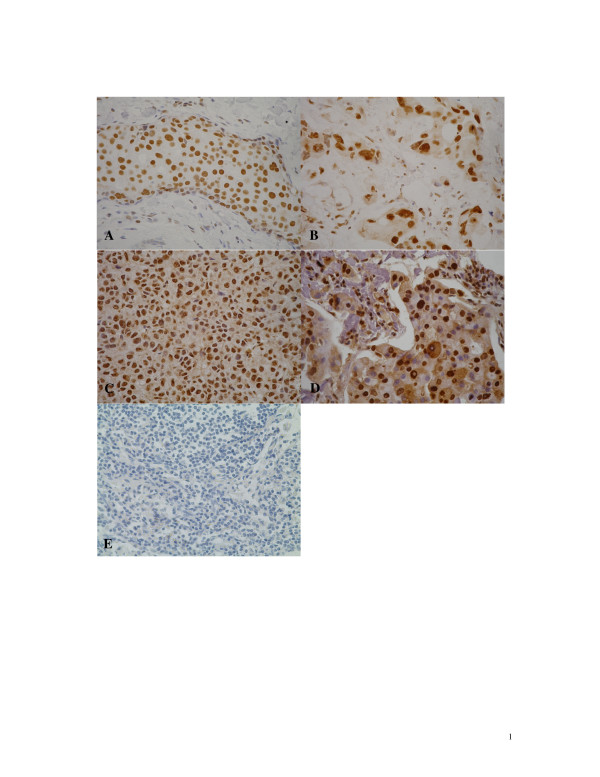
The immunohistochemical staining of Fra-1 in breast carcinomas. A and B, strong nuclear and weak cytoplastic immunostaining were observed in two representative invasive ductal carcinomas. C and D, Strong nuclear and cytoplasmic double staining was very pronounced in two representative invasive ductal carcinomas. E, nonspecific immunoglobulin was used as a negative control. ×400 magnification.